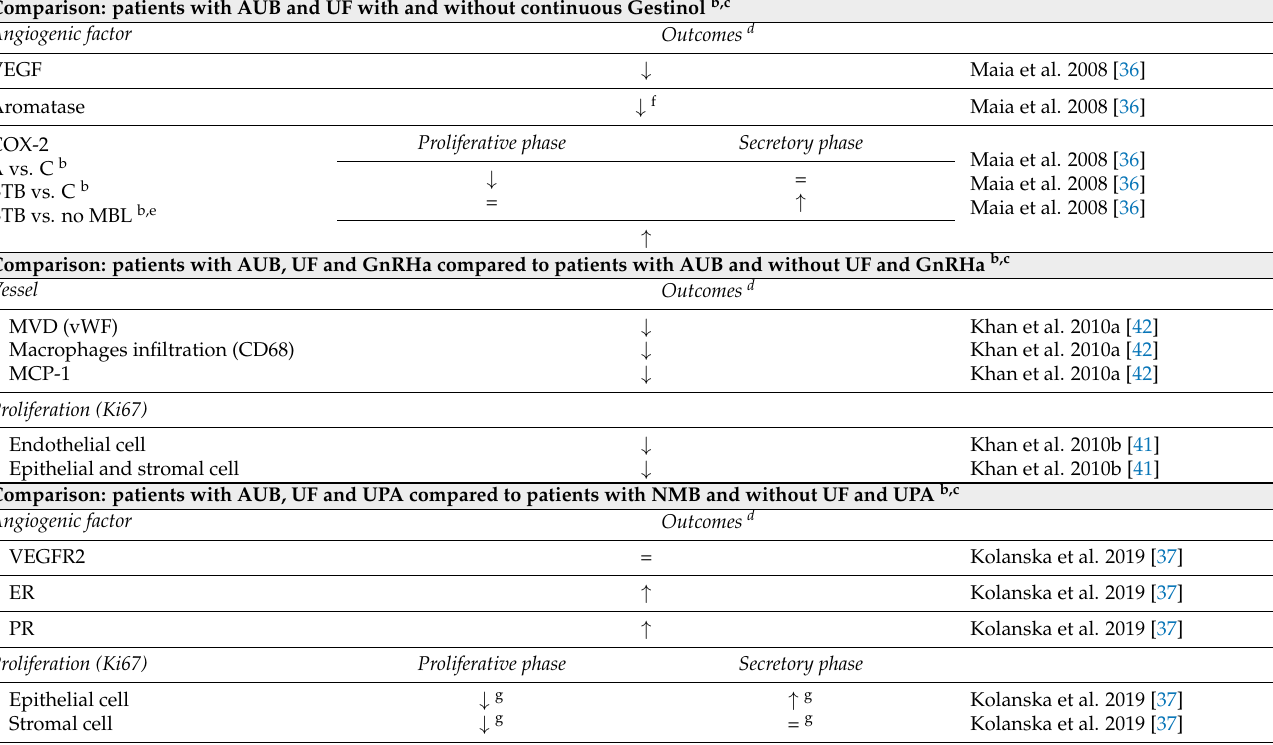
Table 5. Outcomes of the included studies that compared the effect of pharmaceutical therapy (study group) on angiogenesis in the endometrium of patients with uterine fibroids with AUB or without AUB (control